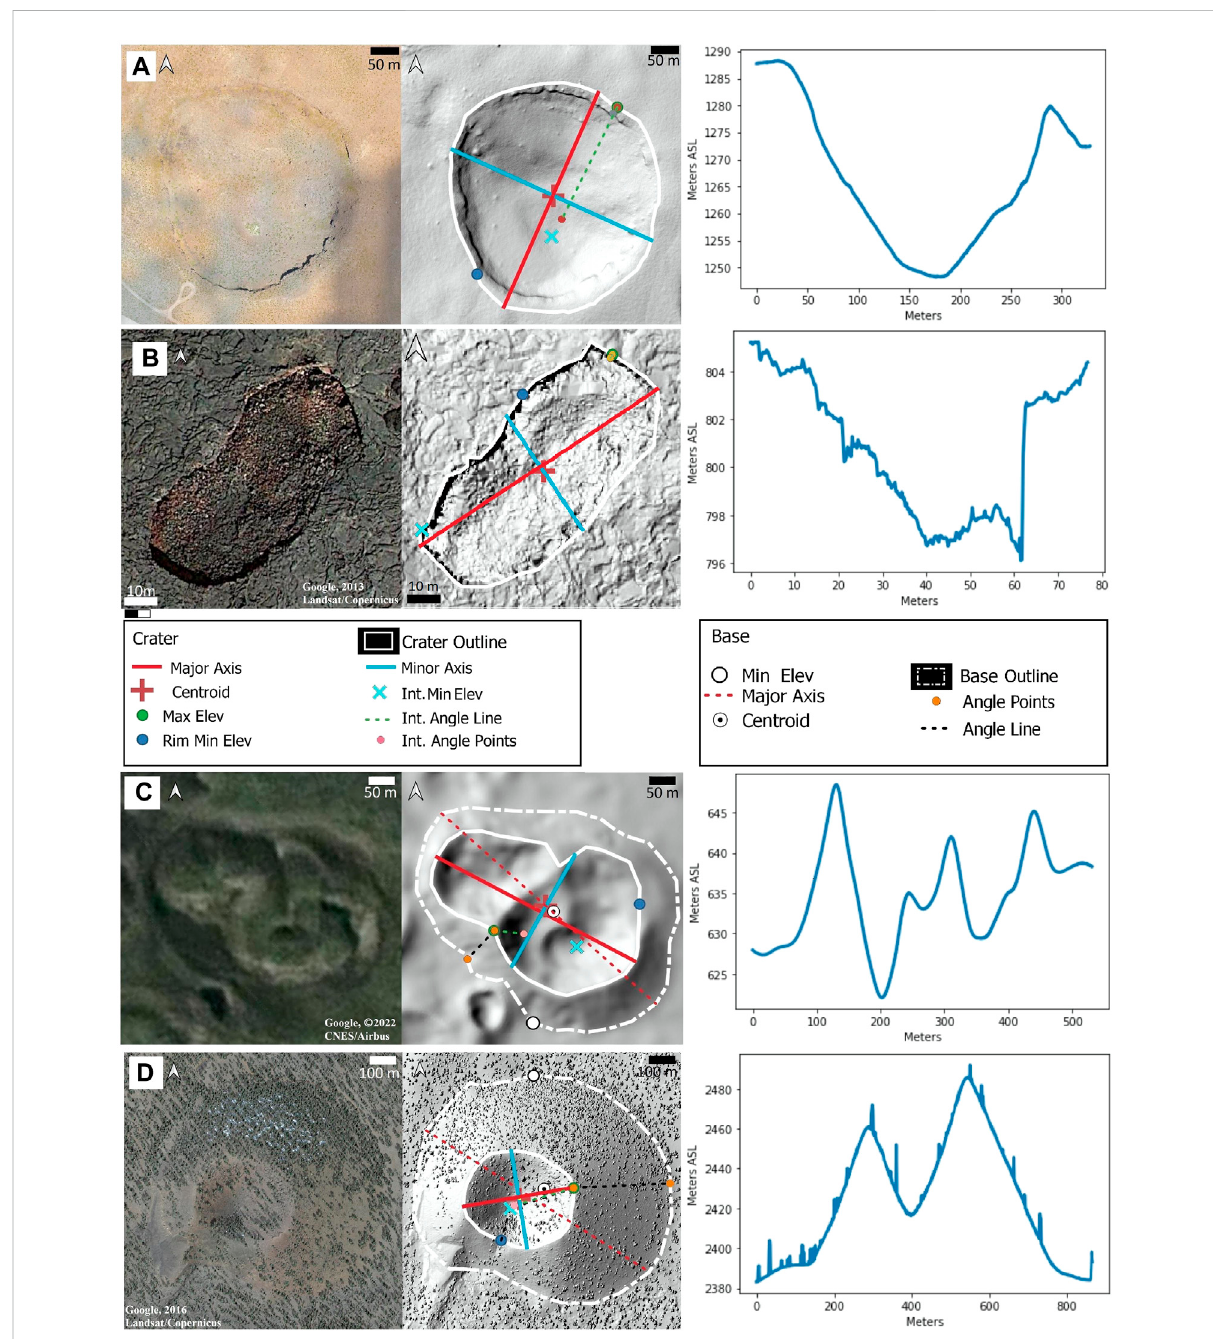
FIGURE 4 Examples of SMILES landforms. (A) Aerial photography (left), DEM-derived hillshade (mid), and topographic pro fi le (right) of West Twin Maar in Diamond Craters, Oregon, United States. (B) Lava collapse feature south of Pu ’ u ‘ O ’ o, Hawaii, United States. (C) Spatter landform in Laki, Iceland. (D) Unnamed scoria conein El Malpais, New Mexico, United States. Visible spikes across thepro fi le are caused bytrees. The topographic pro fi les extend slightly beyond the landform outlines and follow the major chord for A and B, and the base major chord for C and